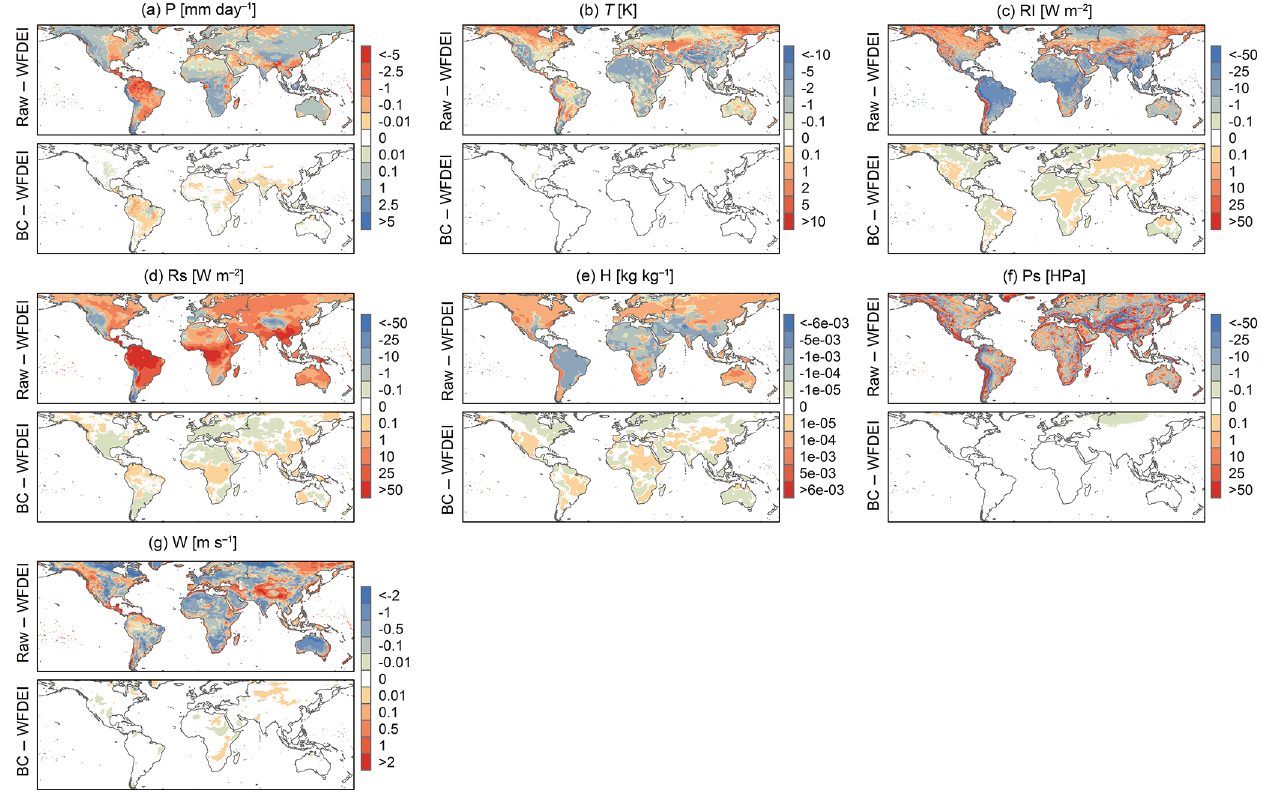
Figure 4. Difference maps, showing initial (raw-WFDEI) and remaining (BC-WFDEI) biases of the GCM ensemble forcing variables: (a) precipitation, (b) temperature, (c) longwave downward radiation, (d) shortwave downward radiation, (e) specific humidity, (h) surface pressure, and (g) wind. Differences are calculated between the long-term annual averages (ANN) of the 1981–2010